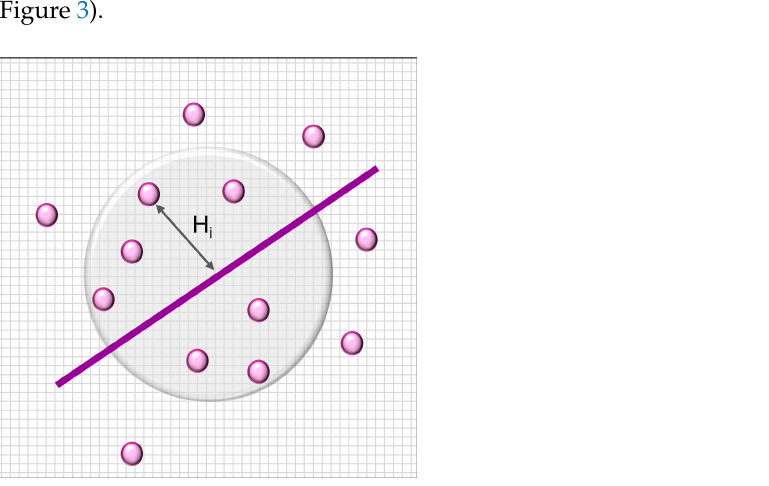
Figure 3. Proposed framework for assessing similarity. H i is the euclidean distance between the i- th subject and the chosen